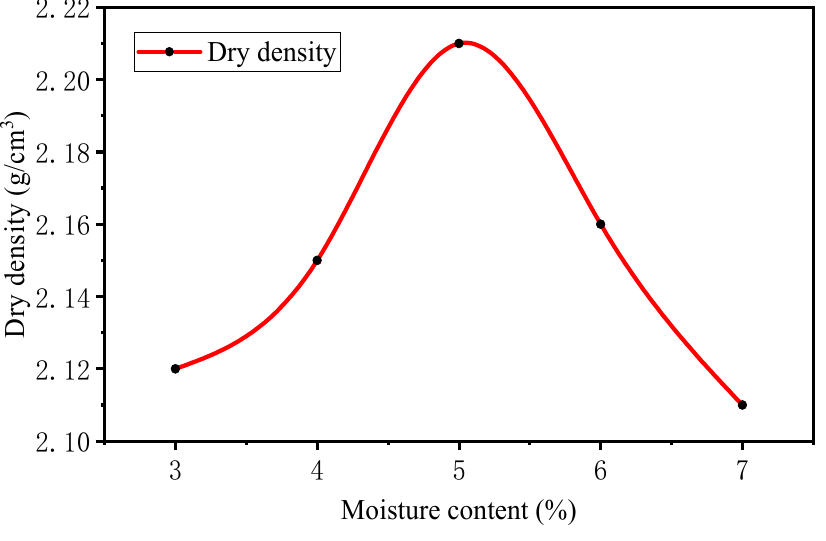
Figure 10. Moisture content and dry density curve of partially replaced aeolian sand with graded gravel.